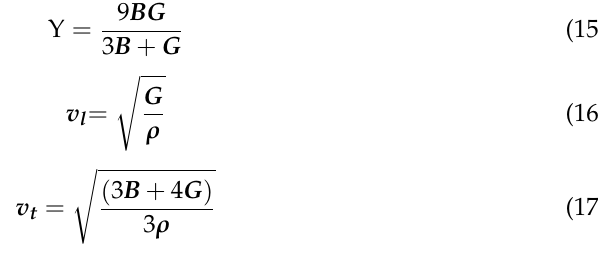
Table 3. Elastic constants ( C 11 , C 12 , and C 44 ), density ( ρ ), longitudinal velocity ( v l ), transverse velocity ( v t ), bulk modulus ( B ), shear modulus ( G ), Debye temperature ( θ D ), and Pugh’s ratio ( B/G ) for PdZrSn and PdHfSn compounds. PdZrSn PdHfSn (PdHfSn) Property (This Work) (This Work) Others